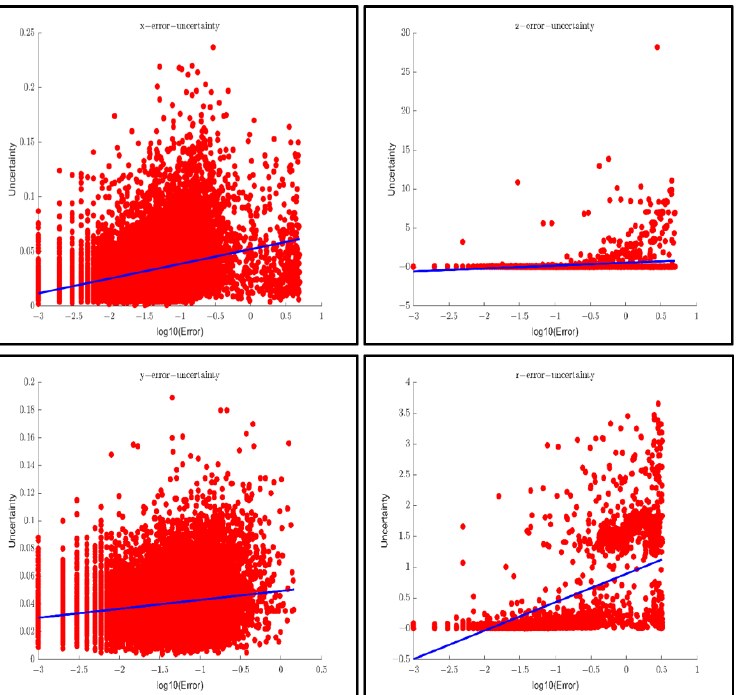
Figure 13. Correlation research between uncertainty and error of Pointpillars (3769 frames) In order: the horizontal direction, longitudinal direction, vertical direction, and orientation of the